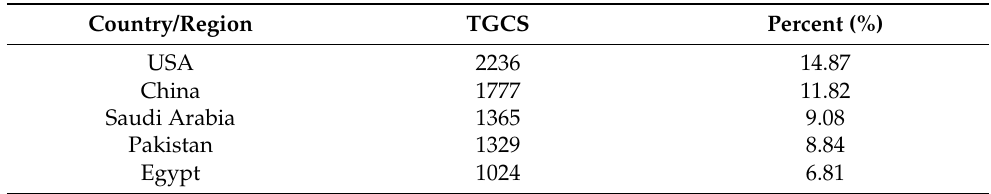
Table 4. The top five most influential countries/regions that published papers regarding NPs enhancing abiotic tolerance in plants from 2008 to 2022.